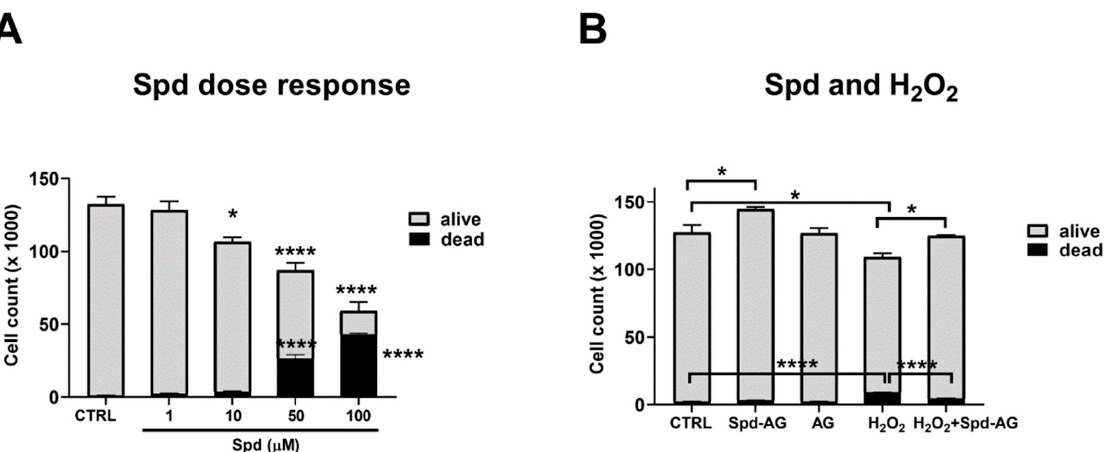
Figure 5. Effect of Spd, AG, Spd-AG and H 2 O 2 in single and combined treatments on C2C12 myoblast viability. ( A ) C2C12 myoblasts were treated with different Spd concentrations (1–100 µ M) for 24 h; ( B ) C2C12 myoblasts were treated with H 2 O 2 0.3 mM, Spd 10 µ M and AG 1mM in various combinations for 24 h. Cell viability was assessed by the trypan blue exclusion assay. Results are expressed as the number of cells ( × 1000). Data presented are the mean ± SEM of three experiments, each performed in triplicate. One-way ANOVA was performed, followed by Bonferroni’s multiple comparison tests for panels A and B, respectively. * p < 0.05; **** p < 0.0001. For the subsequent experiments, H 2 O 2 0.3 mM, Spd 10 µ M and AG 1 mM